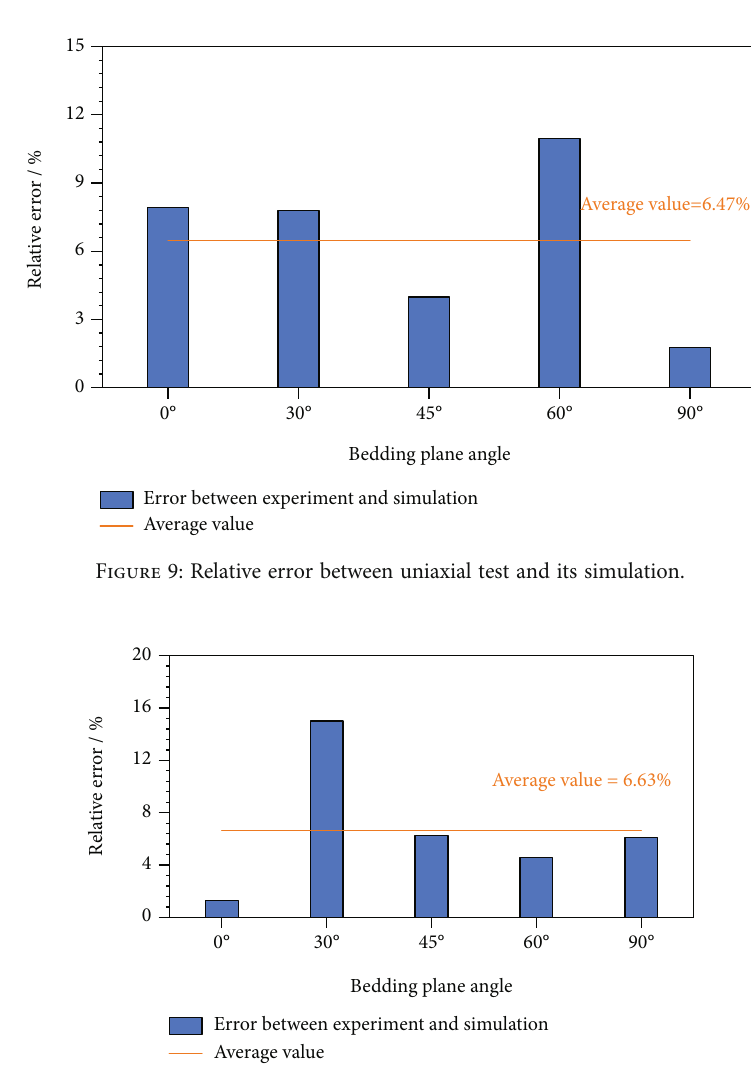
Figure 10: Relative error between Brazilian splitting test and its